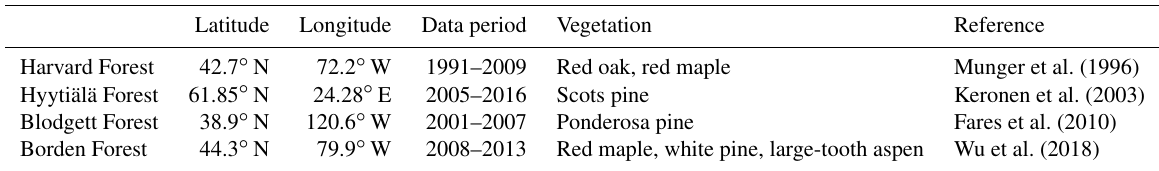
Table 2. Description of long-term O 3 flux measurements.